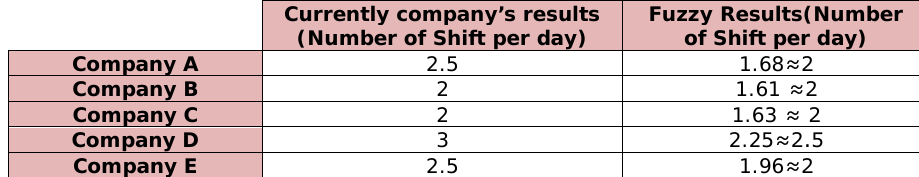
Table 4. “ Comparison of results ( five companies)”. Source: Own contribution